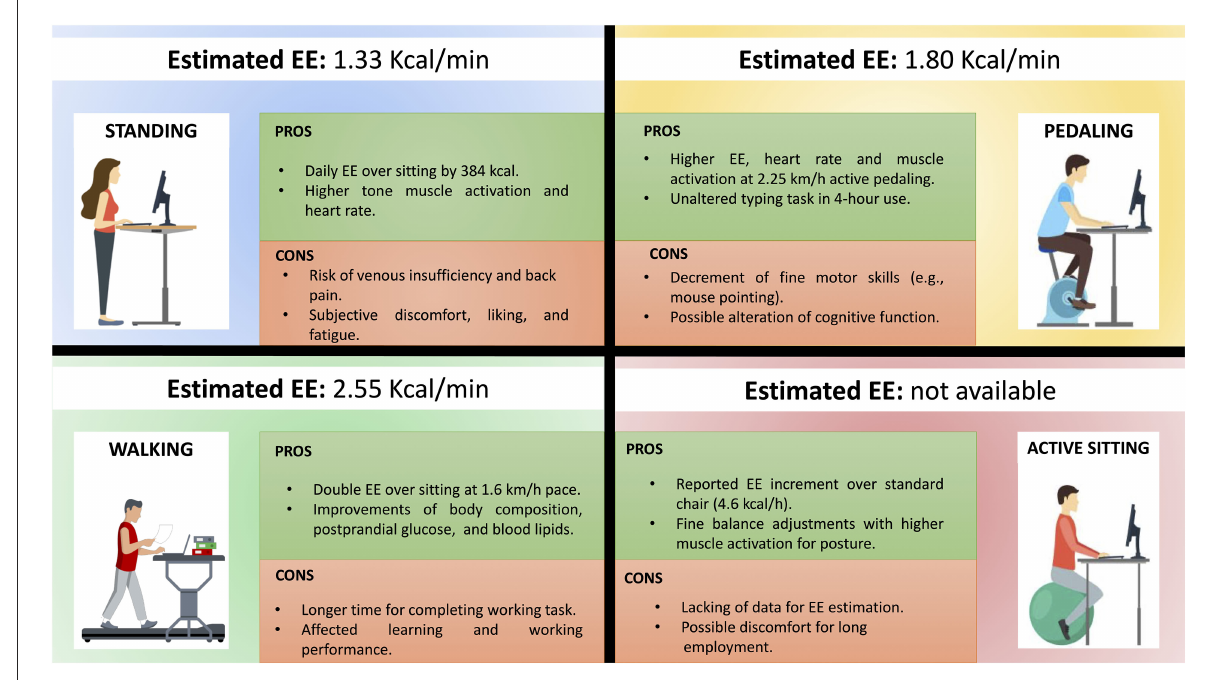
FIGURE2 Alternative workstations. Summary of the main pros and cons of the standing, walking, pedaling, and gymball sitting